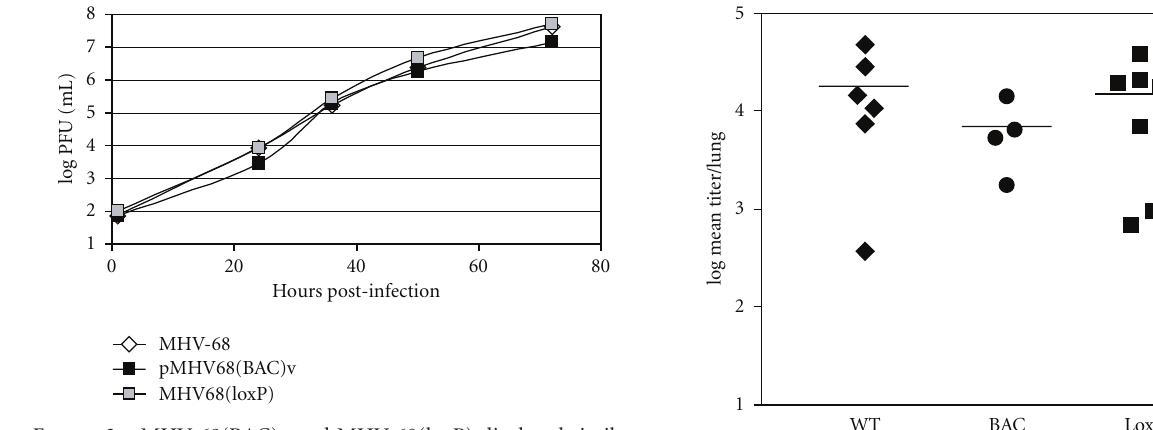
Figure 2: pMHV-68(BAC)v and MHV-68(loxP) displayed similar growth curves to wild-type MHV-68 in vitro . BHK-21 cells were infected with each virus at an MOI of 0.05. The viral titers in cells and the supernatants harvested at various times after infection were determined by plaque assays.